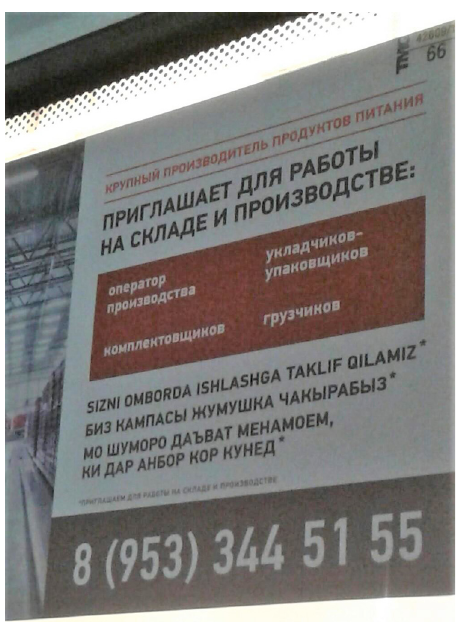
Figure 7: Call for a job at a storehouse, Pr. Prosveshcheniya, St. Petersburg, 2019, LinguaSnapp